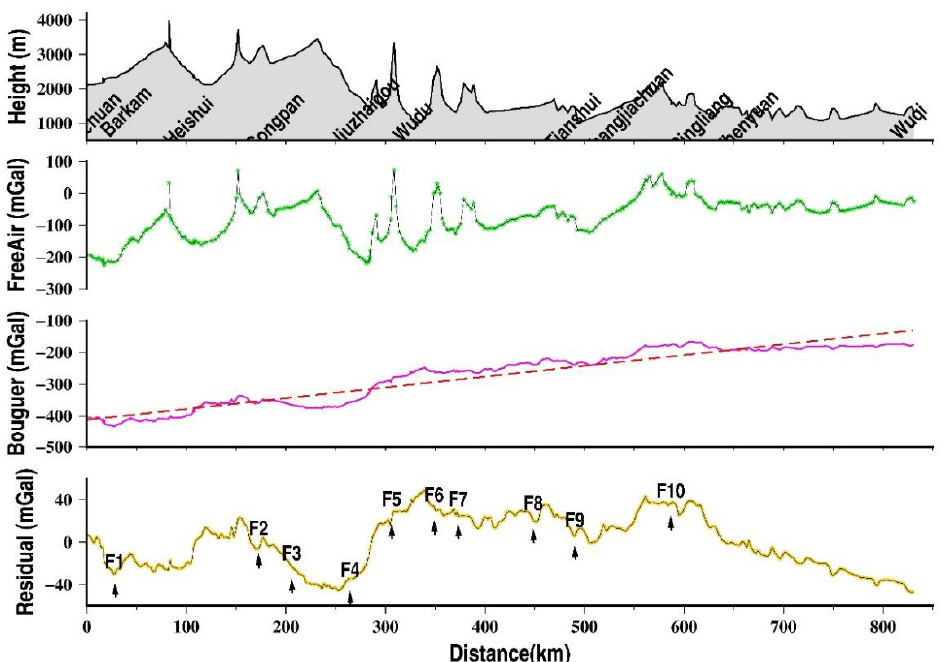
Figure 2. Topography, free-air anomalies, Bouguer anomalies and residual anomalies along with the Barkam–Jiuzhaigou–Wuqi profile (from top to bottom). In the last graph, F1~F10 represents fault, same as Figure 1.